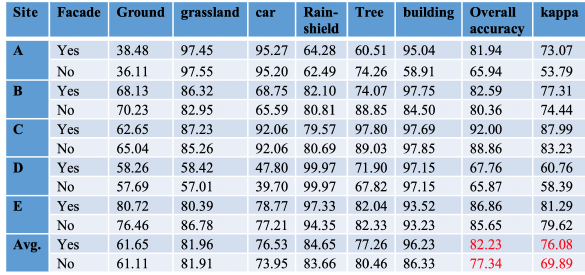
Table 1. The land-cover classification with/without fac¸ade information.